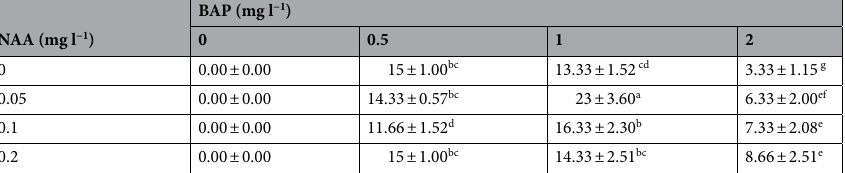
Table 2. Number of induced shoots from cotyledonary node explants. Means with only the same letters are not significantly different at the 5% level based on Duncan’s multiple range test ( p ≤ 0.05). Data shown represent means of number of shoots ± SD ( n = 3).